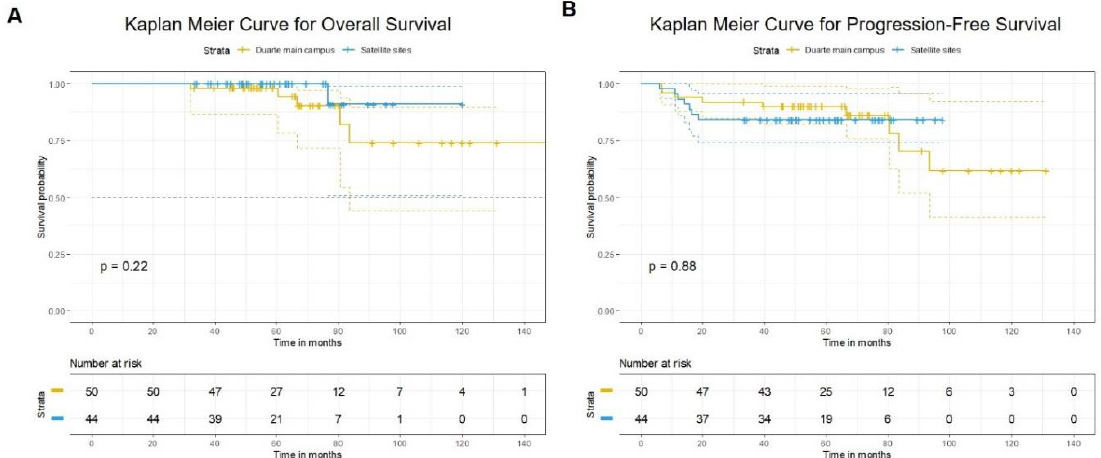
Figure 2. ( A ) Kaplan-Meier curve for overall survival by treatment site and ( B ) Kaplan-Meier curve for progression-free survival by treatment site. progression-free survival by treatment